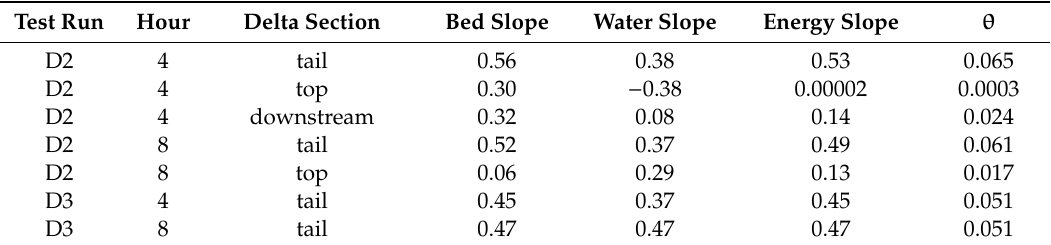
Table 6. Delta tail and top after four and eight hours: bed, water and energy slopes in percent (%), negative signs indicate rising slopes, Shields parameter θ